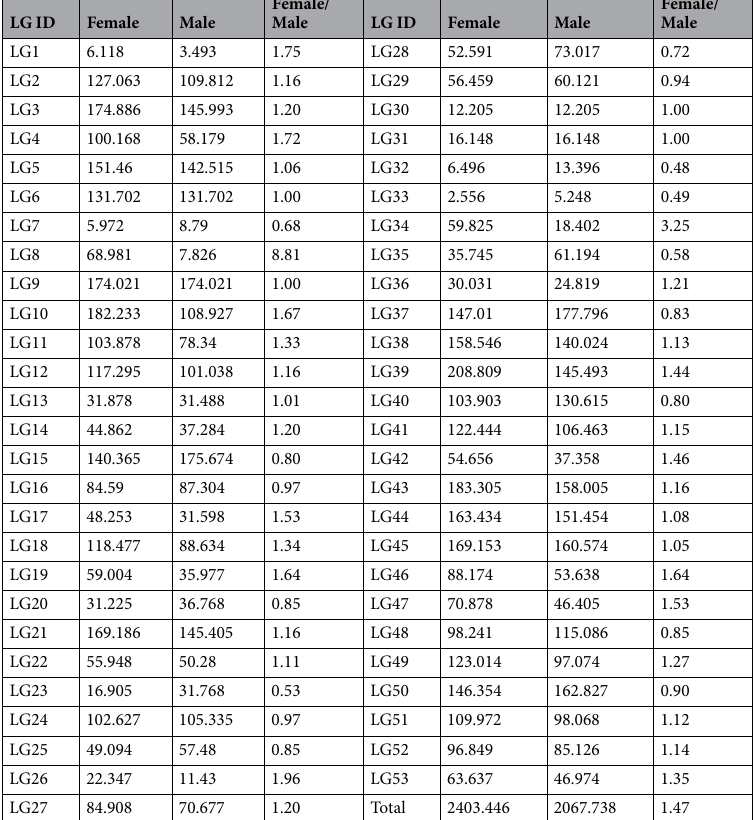
Table 5. Recombination rates in male and female